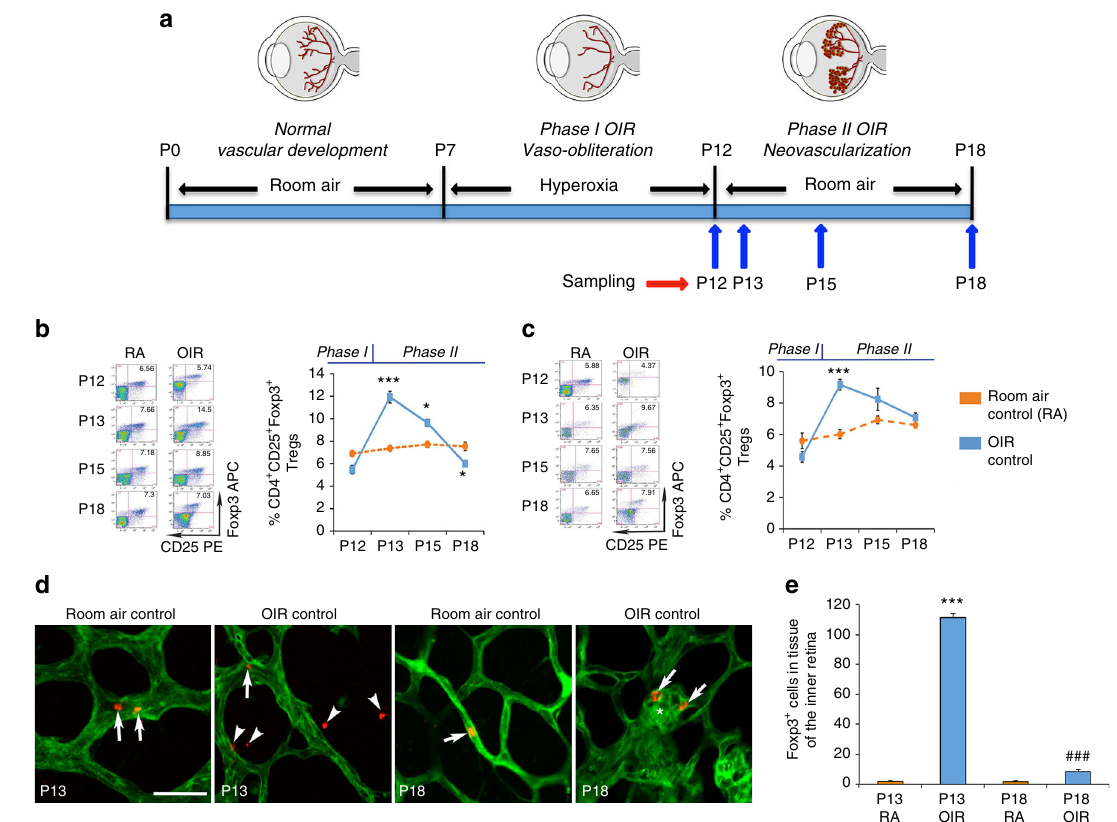
Fig. 1 Tregs are transiently increased in OIR and penetrate the retina. a Cohorts of C57BL/6J mice were studied during phase I OIR at postnatal day ( P ) 12 and phase II OIR at P13, P15, and P18. Comparisons were made to age-matched room air controls (RA). FACS of pooled lymph nodes b and spleen c revealed that Foxp3 + Tregs were increased in phase II OIR at P13 and declined to the level of RA or below by P18 (enlarged FACS plots in Supplementary Fig. 2). Fluorochromes are phycoerythrin (PE) and allophycocyanin (APC). n = 13 RA mice at P13 and P18. n = 7 OIR mice at P13 and P18. * P < 0.05 and *** P < 0.001 to age-matched RA (one-way ANOVA with Mann – Whitney U test). d Representative confocal images of fl at mounted retina from Foxp3 rfp mice at P13 and P18 labeled with isolectin ( green ) to show blood vessels. Scale bar , 50 μ m. In RA, Foxp3 + cells ( red ) were mainly located within blood vessels ( arrows ). In OIR at P13, Foxp3 + cells were increased and mainly located in retinal tissue ( arrowheads ). In OIR at P18, the number of Foxp3 + cells had declined and were localized to tufts of neovascular blood vessels ( asterisk ) with few cells in retinal tissue. e Foxp3 + cells in tissue of the inner retina (one- way ANOVA with Mann – Whitney U test). *** P < 0.001 to all groups. ### P < 0.001 to RA. n = 16 RA mice and OIR mice at P13. n = 16 RA mice and 12 OIR mice at P18. Values are expressed as mean ±